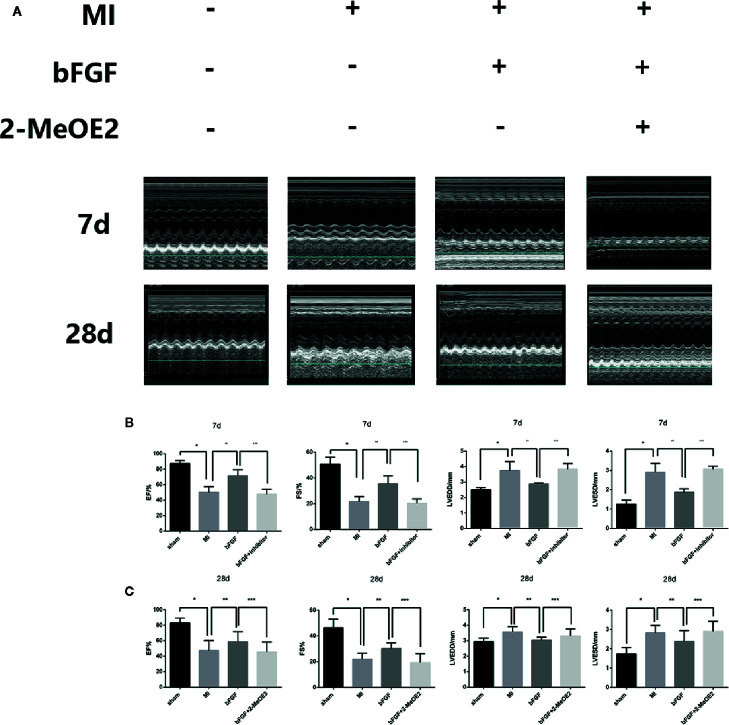
bFGF preserved LV function in mice. (A) Effects of bFGF on the infarcted area and LV function. The infarcted areas are echocardiography photos from the sham, MI, bFGF, and bFGF + 2-MeOE2 groups. (B, C) EF, FS, LVSD, and LVPW values were compared among the groups. EF, ejection fraction; FS, fraction shortening; LVSD, left ventricular end-systolic diameter; LVPWs, left ventricular posterior wall thickness at end of systole. *
P<0.001 vs. sham group. **
P<0.01 vs. MI group. ***
P<0.01 vs. bFGF group (n=5).